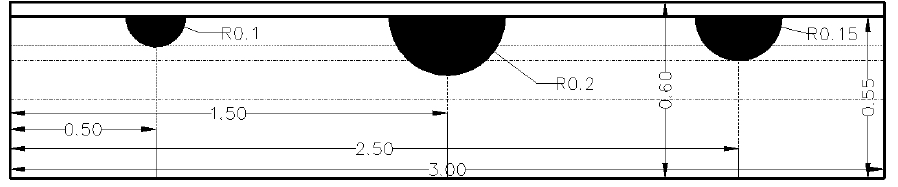
Figure 3. Schematic diagram of a drip irrigation SWB model. Unit: Meters.